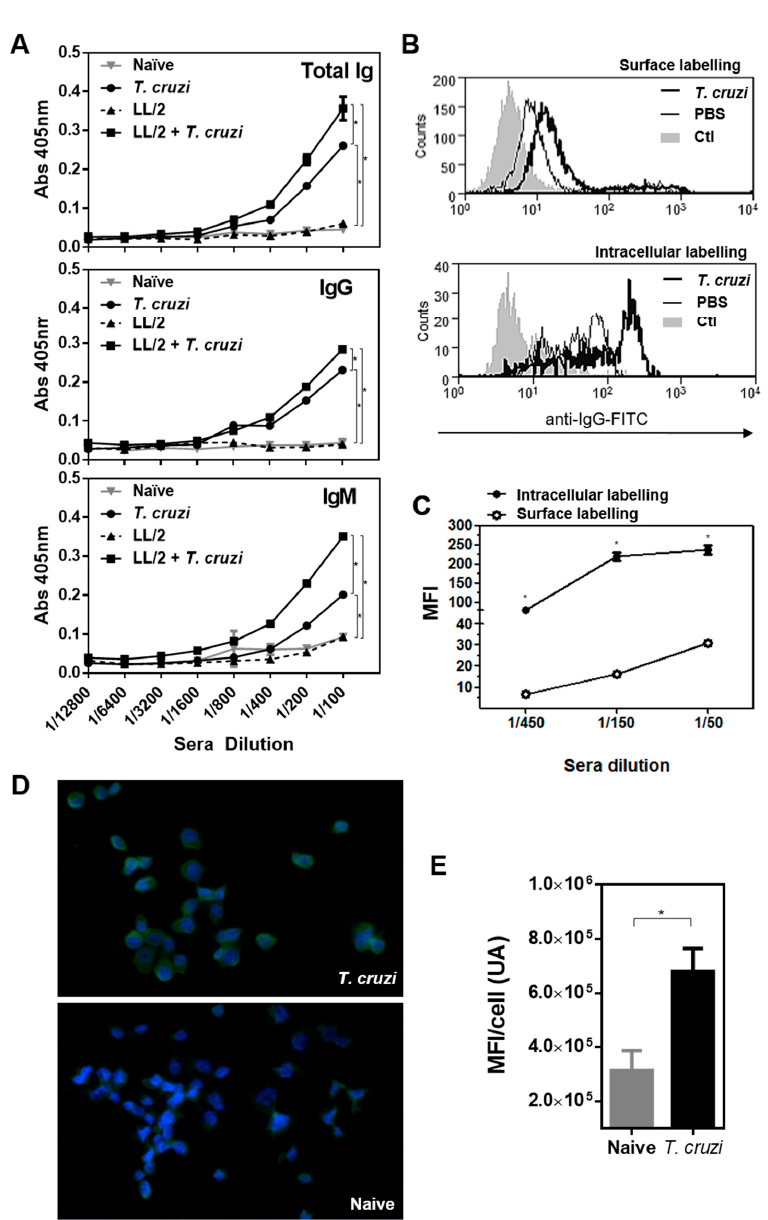
Figure 5. Antibodies induced after T. cruzi immunisation recognise tumour cells: ( A ) Antibody levels determined by ELISA in sera from T. cruzi -immunised and control mice injected or not with LL/2 tumour cells. ( B ) Histogram plots showing antibody recognition of membrane and cytosolic antigens on LL/2 cells. Flow cytometry analyses were carried out on permeabilised (intracellular staining) or non-permeabilised (surface staining) LL/2 tumour cells incubated with sera (diluted 1:100) collected from animals immunised with T. cruzi lysate. Controls consisted of sera from PBS-inoculated mice (PBS) or cells incubated with secondary antibody only (Ctl). Five thousand events were collected and gated on FSC vs. SSC dot plot. ( C ) Median fluorescence intensity (MFI) representing antibody recognition of surface and intracellular antigens on LL/2 cells, respectively. Different sera dilutions (1:50, 1:150, 1:450) were used, and MFI values were obtained after subtracting the corresponding pre-immune sera reactivity at the same dilution. ( D ) Antibody recognition of LL/2 cells by immunofluorescence (zoom 200 × ). ( E ) Antibody recognition of LL/2 cells by immunofluorescence was quantified with Image J software and represented as the mean fluorescence (MFI) per cell. Representative results from at least two independent experiments are shown ( ± SEM, indicated by error bars). Asterisks represent statistically significant differences with p < 0.05 by student t